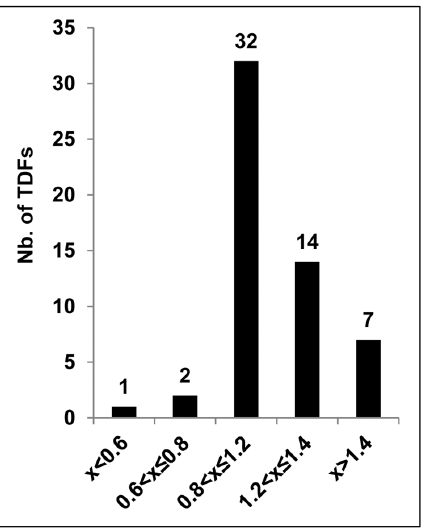
Figure 3. Classification of the 56 TDFs according to their expression levels. The 56 transcript-derived fragments are classified according to the ratio of their expression levels in ARE-treated J 2 relative to those in water-treated controls (2 biological repeats).